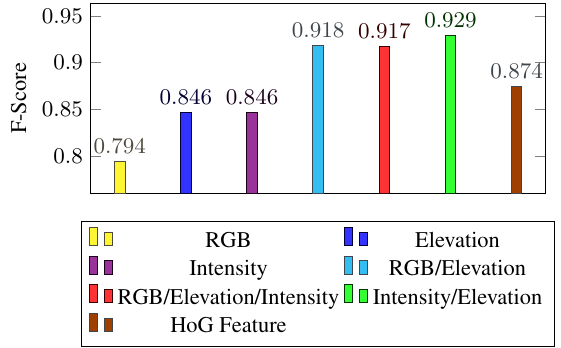
Figure 9. F-Scores for the CNN feature training using a SVM.